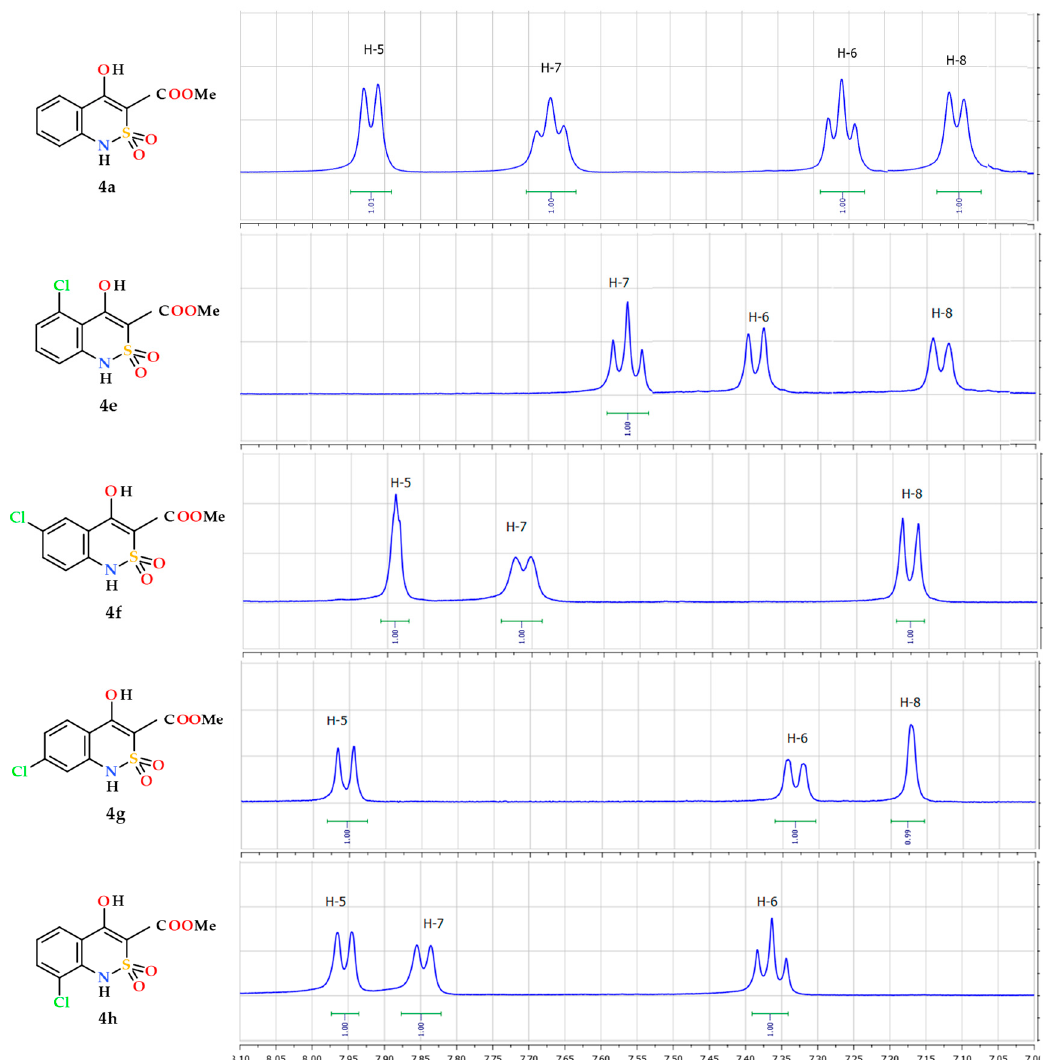
Figure 2. Fragments of 1 H-NMR spectra (the signals of aromatic protons) of ester 4a and of its chloro-substituted analogues 4e – 4h .